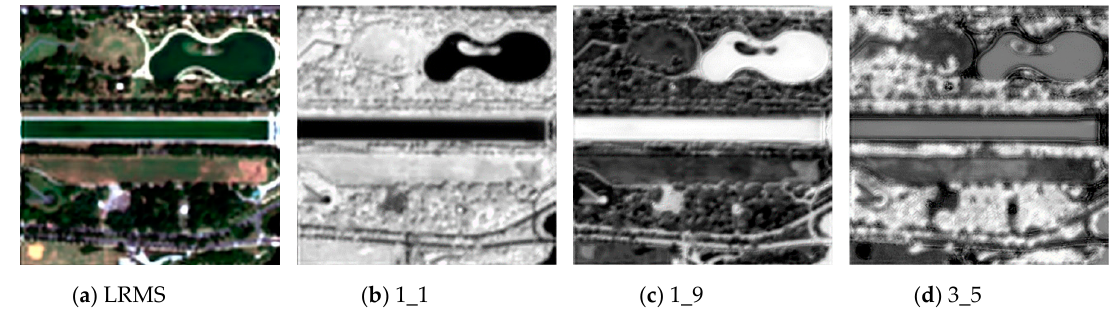
Figure 3. Input and intermediate results of a WorldView-2 sample. ( a ) Input of the CNN model. ( b ) The feature map obtained using filter #1 of the first convolutional layer. ( c ) The feature map obtained using filter #9 of the first convolutional layer. ( d ) The feature map obtained using filter #5 of the third convolutional layer.